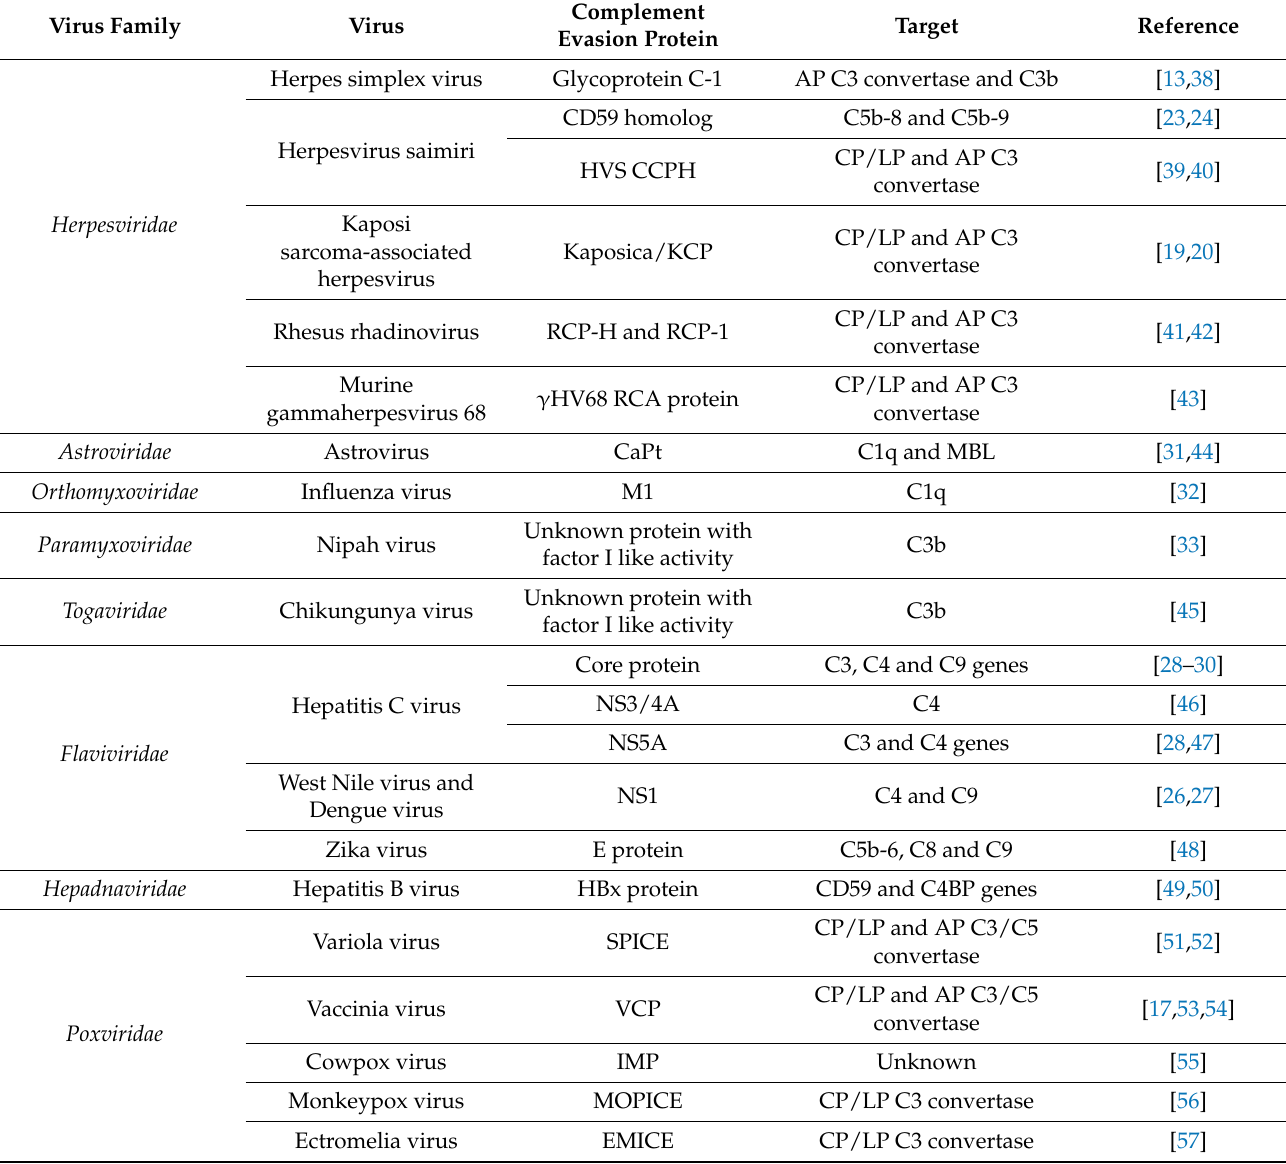
Table 1. Viruses and their complement